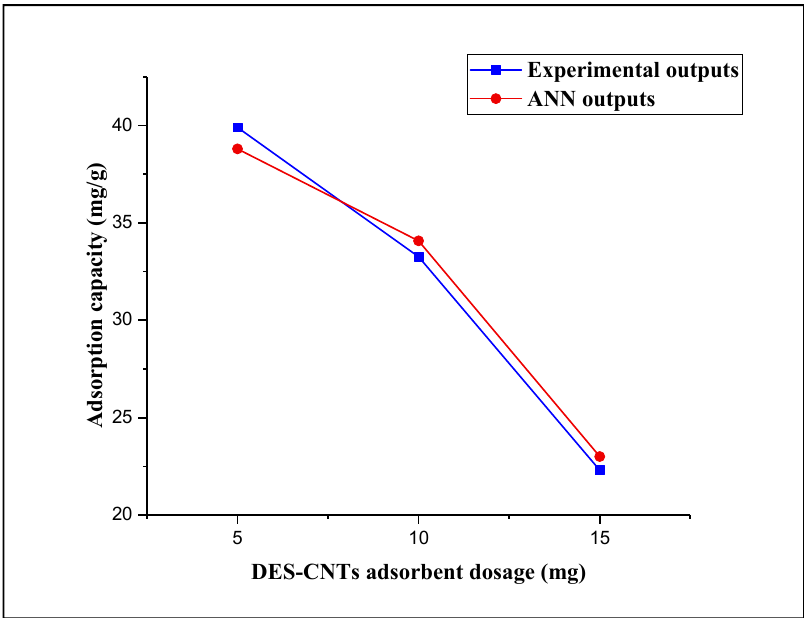
Figure 7. Experimental and FBPNN outputs as a function of the adsorbent dosage.